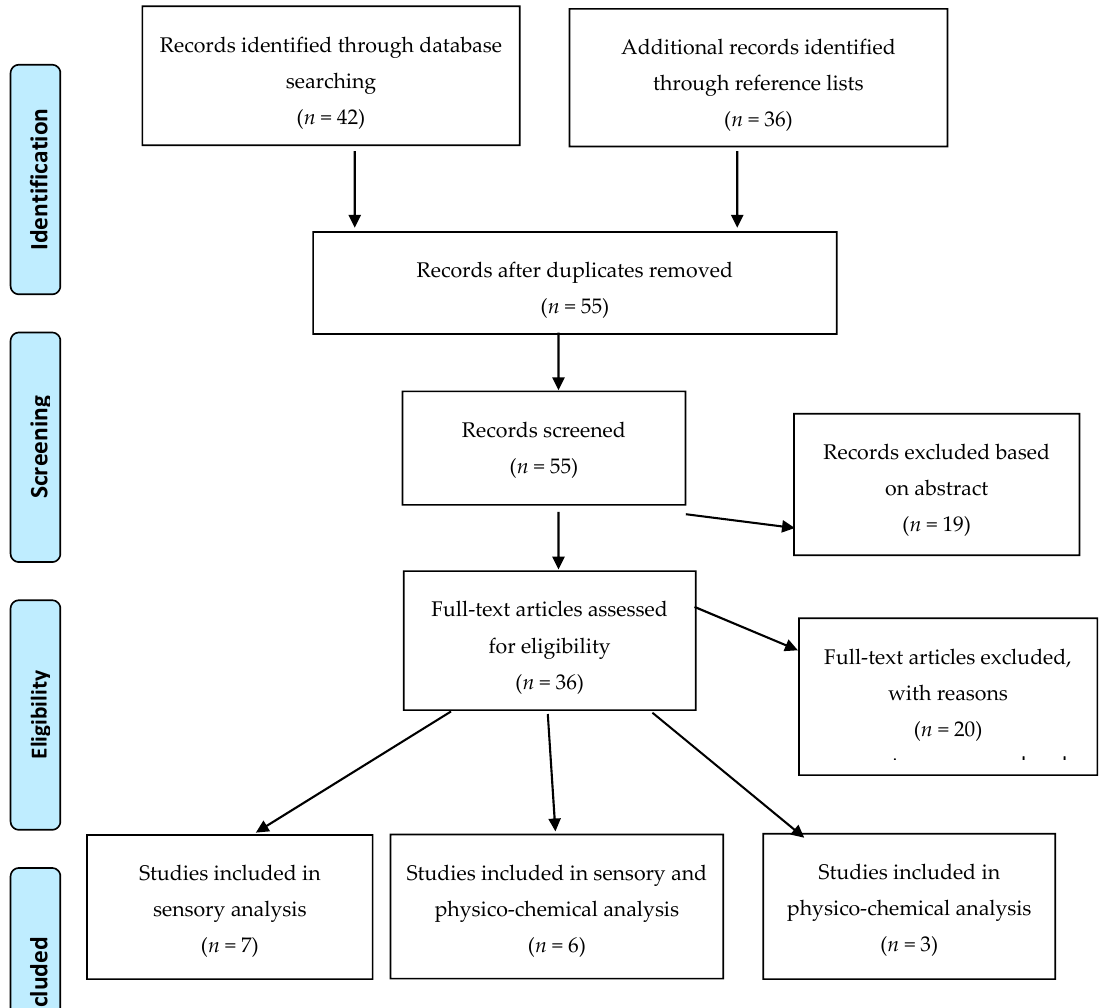
Figure 1. PRISMA